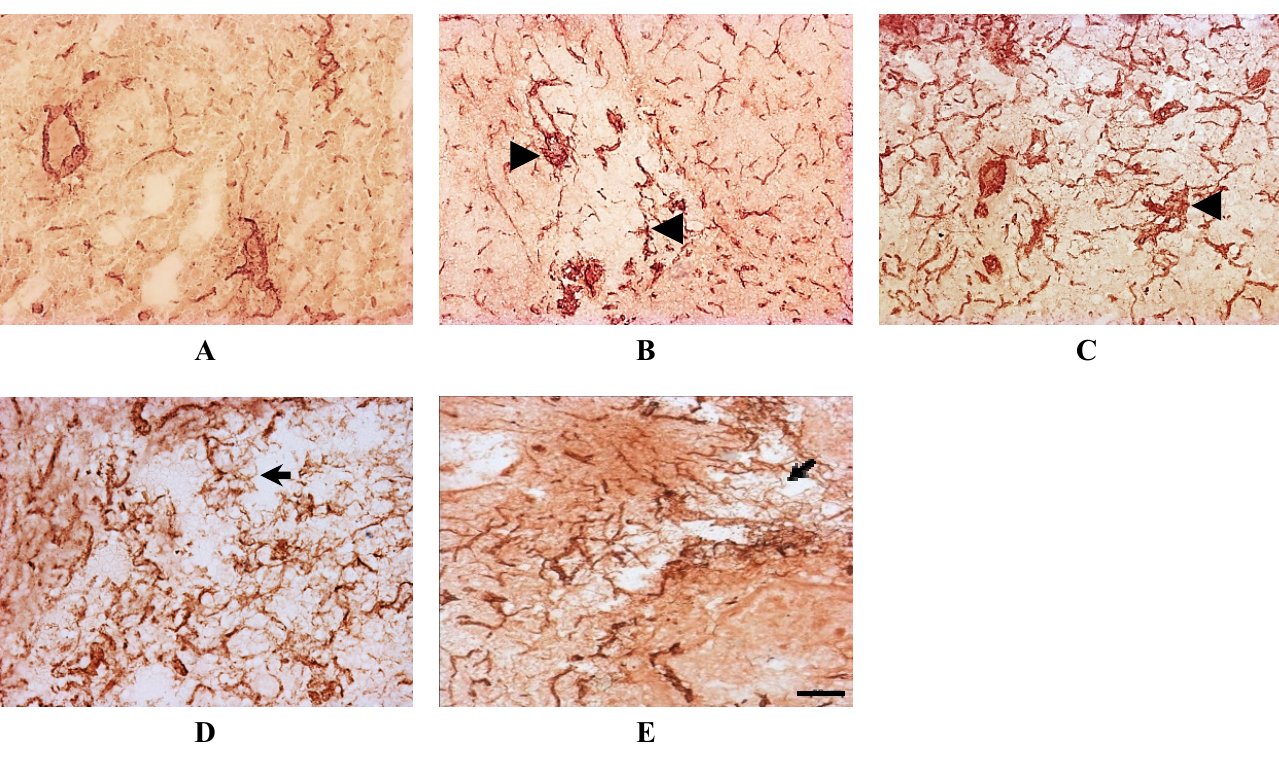
Figure 2. Angiogenesis in the ET-1 induced stroke affected brain. Immunohistochemical photomicrographs of vWF staining in the ipsilateral core cortex at 6 h, 3, 7, 14 and 28 days post-stroke ( A – E respectively). Arrow heads indicate sprouting vessels and short arrows point to microvascular development by 14 and 28 days. Scale bar = 50 μ M. Blood vessels were quantified in situ using vWF stained sections and point counted using Metamorph imaging software ( F–O ). A significant increase in the number of blood vessels was detected 7, 14 and 28 days after stroke in the ipsilateral core cortex ( H – J respectively) and also at 3, 7, 14 and 28 days in the core ipsilateral striatum ( L – O respectively) in comparison to respective contralateral mirror regions [6 h ( n = 4); 3 days ( n = 5); 7 days ( n = 6); 14 days ( n = 4); and 28 days recovery ( n = 4)]. Data presented as mean ± S.E.M. * p < 0.05, ** p < 0.01, *** p < 0.001 compared with the contralateral side expressed as